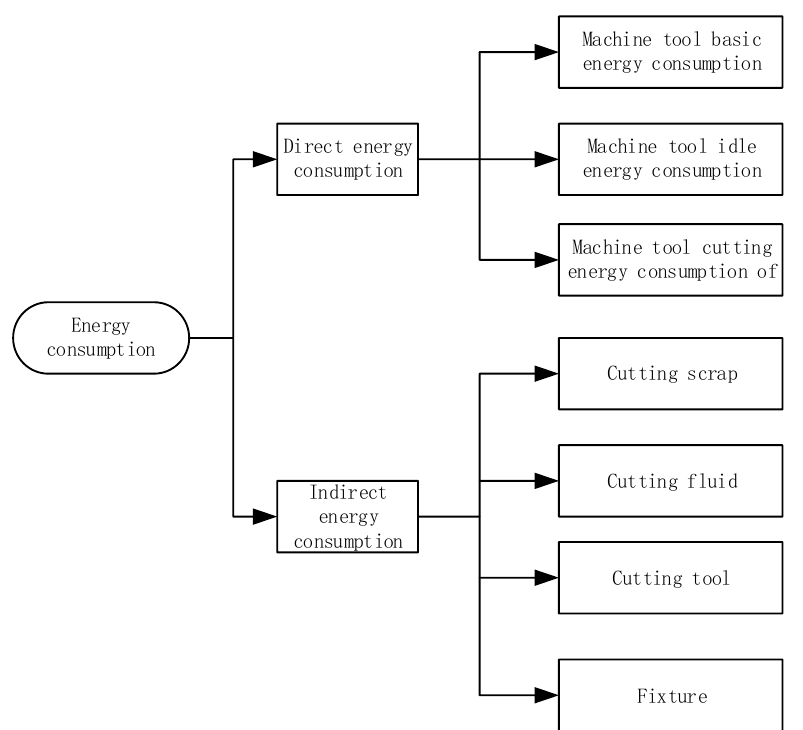
Figure 1. Influencing factors of energy consumption in gear machining process.